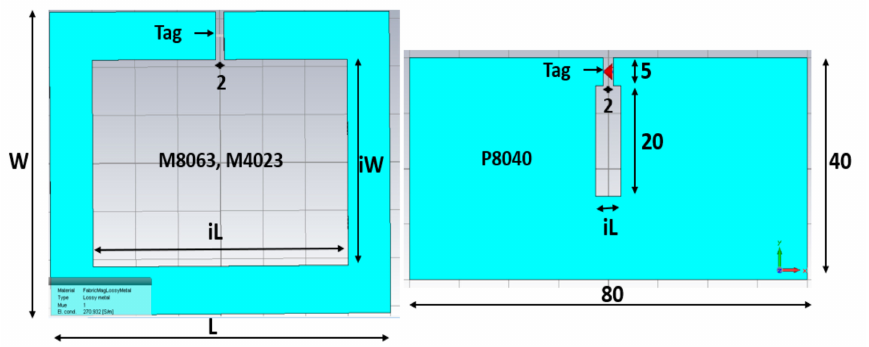
Figure 2. Parameters of three CFTA antenna designs (M8063, M4023,